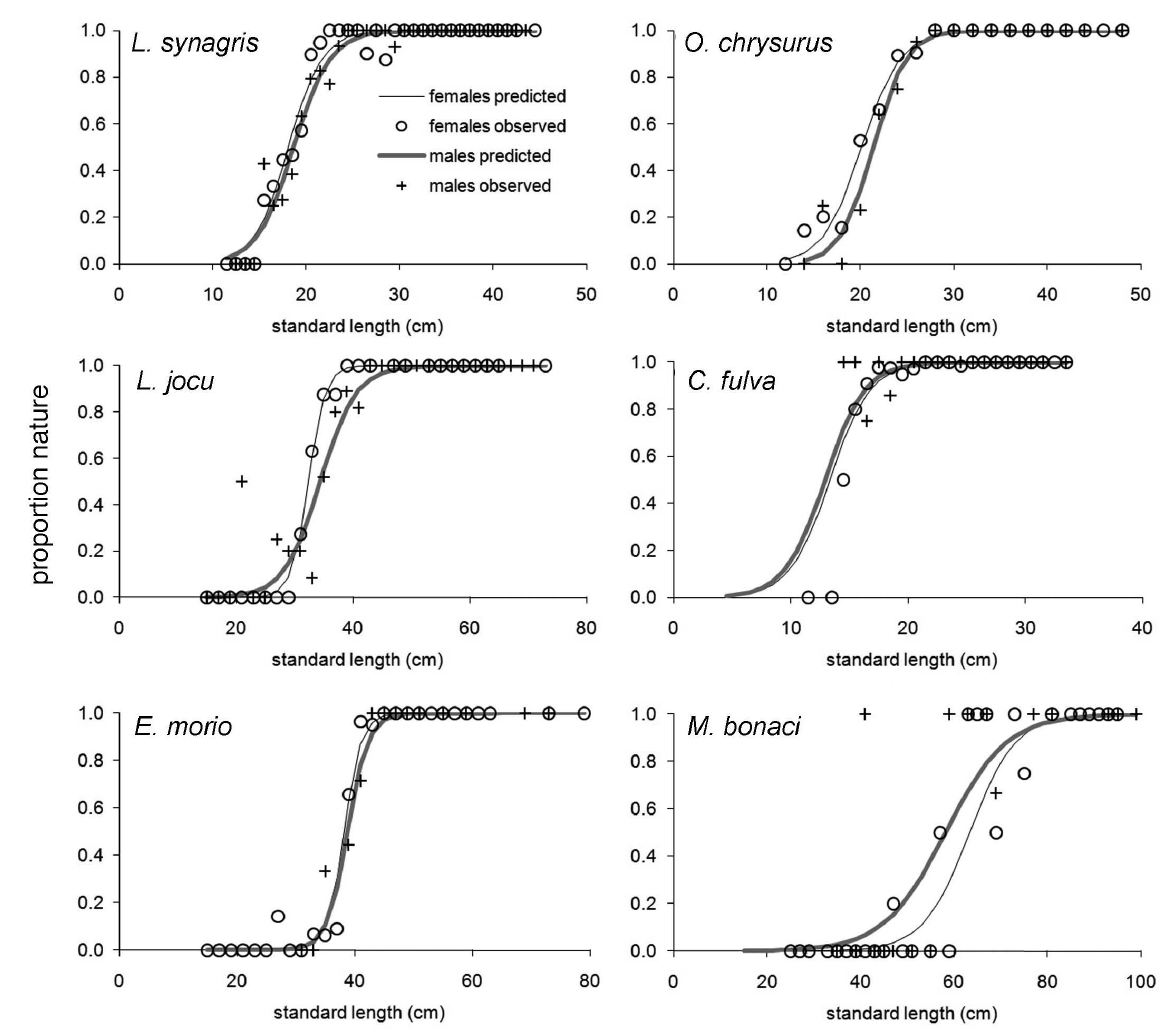
Fig . 4. – Observed and predicted values of size at maturity (L